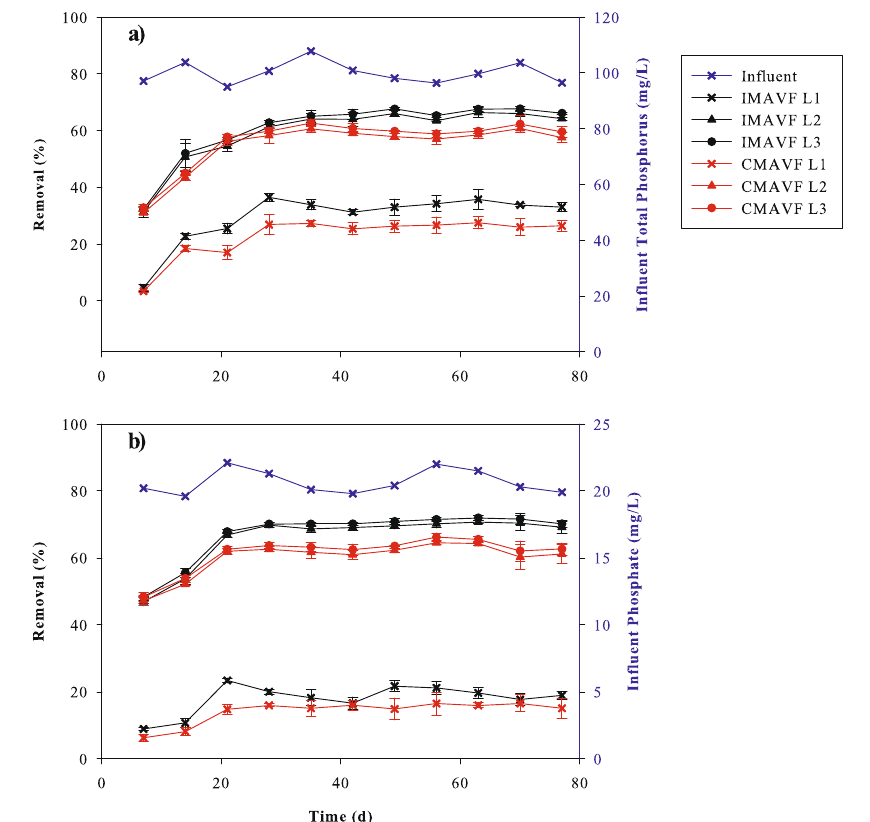
Fig. 3 Intermittent feeding and Total Phosphorous, and Phosphate. Effect of intermittent feeding on ( a ) TP and ( b ) PO 4 removal. IMAVF intermittently fed macrophyte assisted vermi fi ltration, CMAVF Continuously fed macrophyte assisted vermi fi ltration. Error bars: standard deviation created using replicated ( n = 3) set-ups for each experimental condition. Three layers placed at 0 – 30 cm (L3), 30 – 60 cm (L2), and 60 – 100 cm (L1) from the bottom, containing gravel, alum, and soil mix,